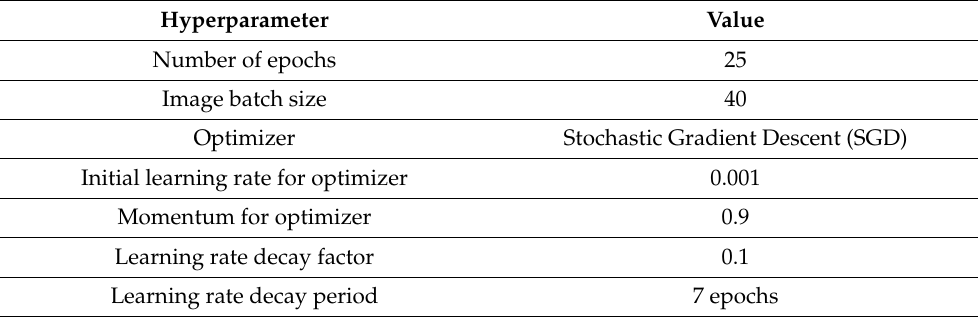
Table 2. Image Classification Hyperparameters Used for all